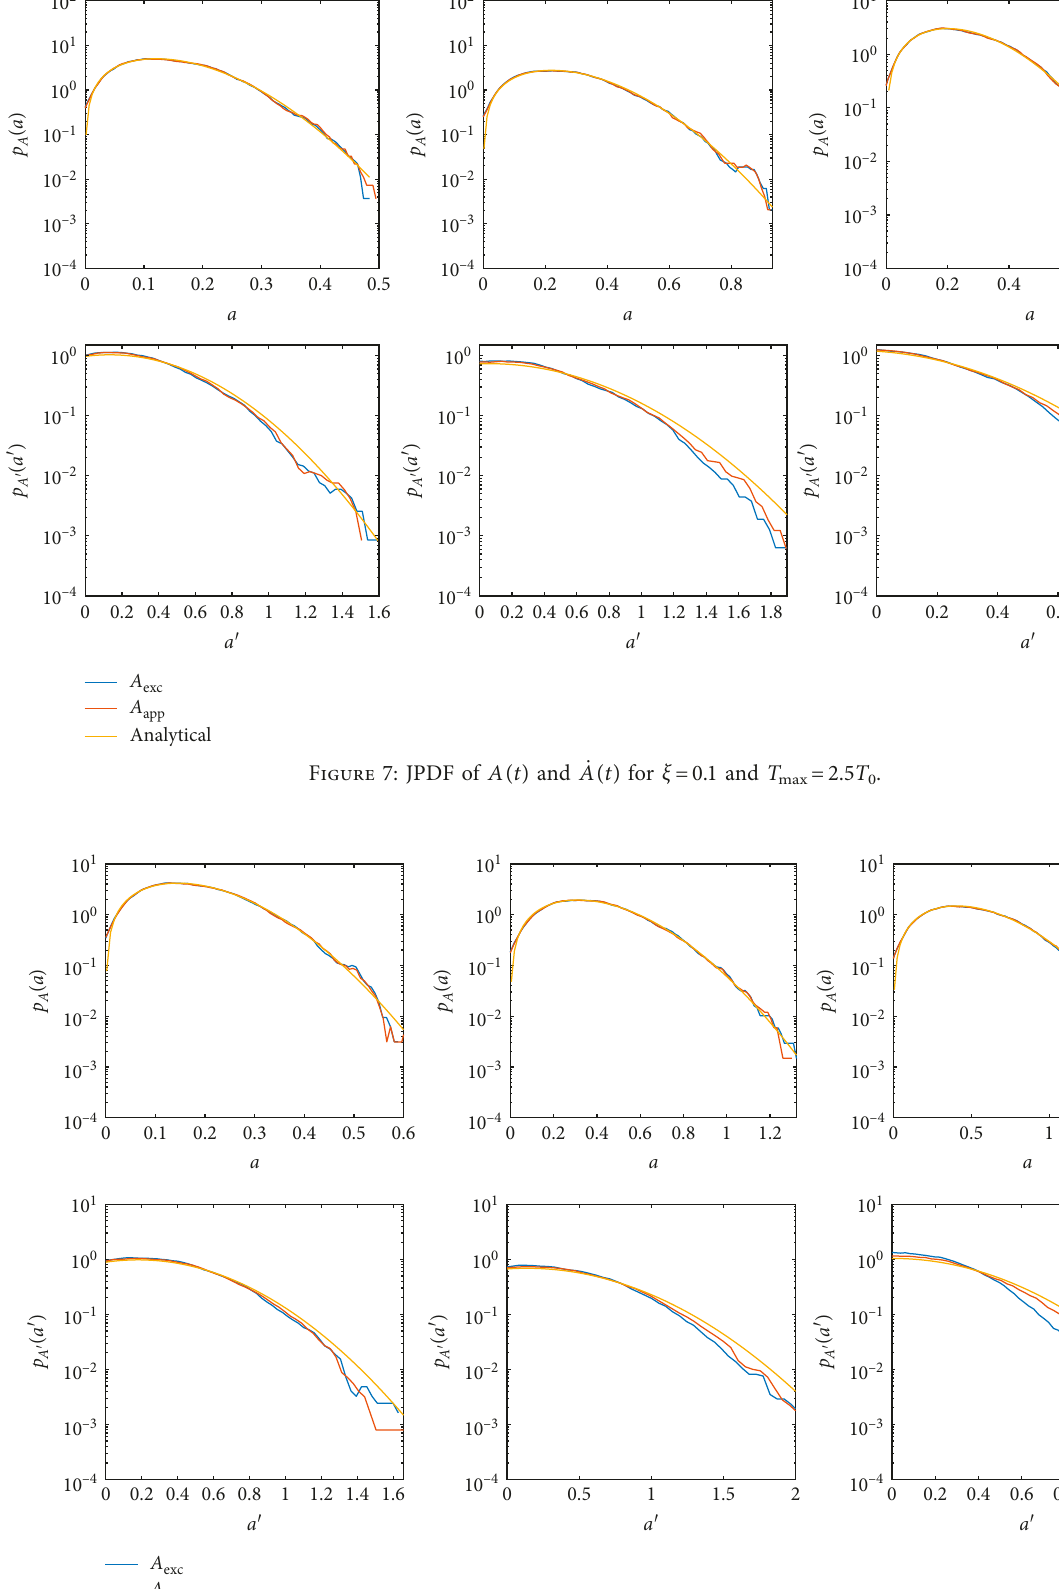
Figure 8: JPDF of A